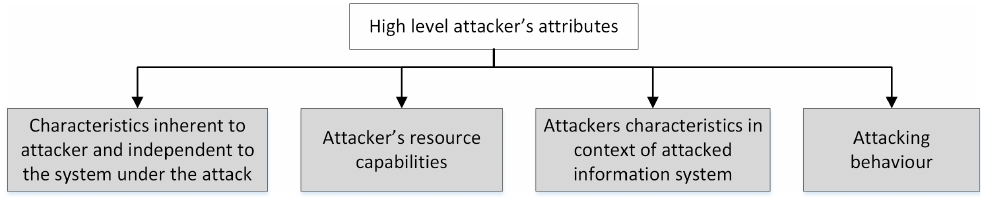
Figure 1. Main groups of the high-level